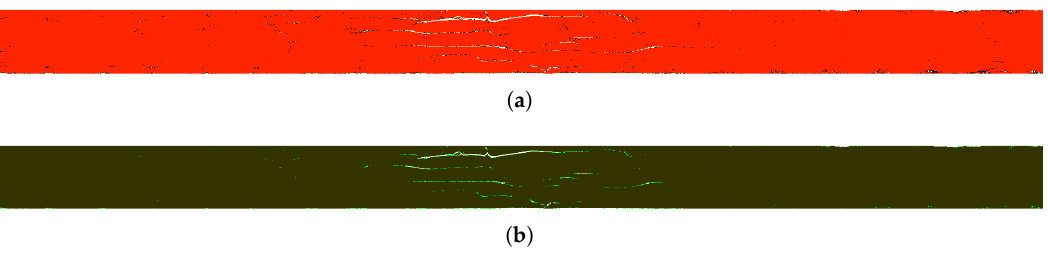
Figure 4. The selected 2D slice with labeled clusters ( a ), and the same slice after preclassification ( b